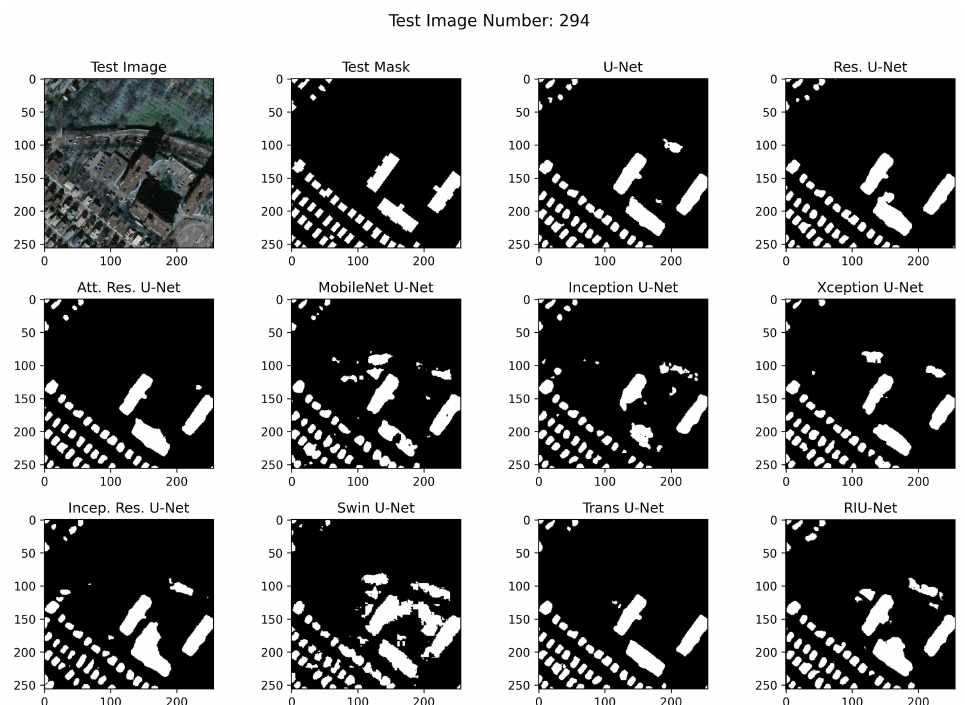
Figure 12. Massachusetts Large test set image no. 294 segmentation